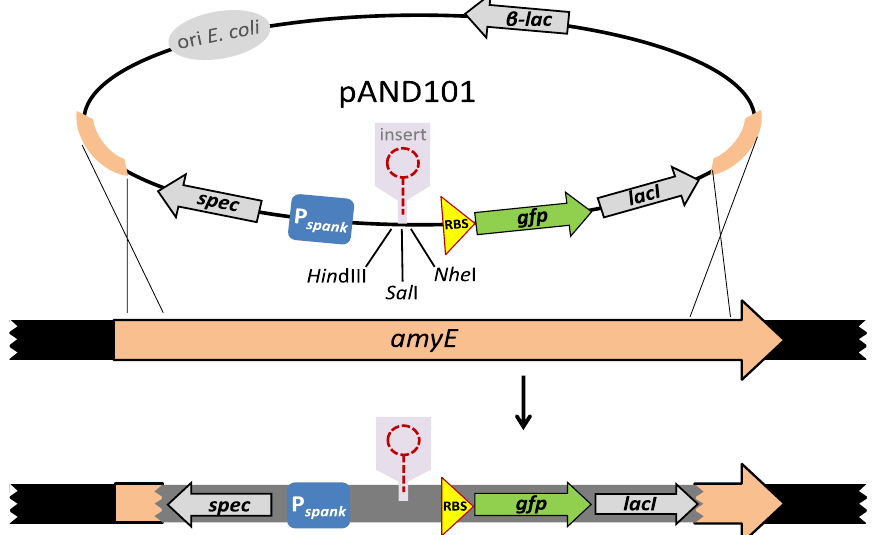
Figure 2. Features of the transcription terminator screening vector pAND101. Top: Vector pAND101 is a derivative of the B. subtilis amyE integration vector pDR110. A colE1 origin of replication ( ori E. coli ) confers replication in E. coli and the β-lactamase gene (β-lac) provides resistance to ampicillin in E. coli . The remaining part of the vector corresponds to the cassette that becomes integrated at the amyE locus when the plasmid is introduced into B. subtilis cells by transformation. The regions cor- responding to the N- and C-terminal regions of the amyE gene are shown in orange. Bottom: Sche- matic presentations of the double cross-over recombination event. The genomic configuration of the B. subtilis amyE region of the chromosome in the parent strain and the resulting transformants are shown below the circular plasmid. The thick black lines at the two ends indicate B. subtilis chromo- somal DNA. The cassette that becomes integrated via double cross-over at the amyE locus (not to scale) encompasses the spectinomycin resistance gene (gray arrow indicated with “spec”), the lacI gene encoding the P spank repressor (gray arrow indicated with “ lacI ”), which is under the control of a constitutive promoter, and the gfp reporter gene (green arrow indicated with “ gfp ”) that is under the control of the IPTG-inducible P spank promoter (blue box indicated “P spank ”). The unique restriction sites Hin dIII, Sal I and Nhe I are located in between the P spank promoter and the ribosomal binding site (RBS, yellow triangle) of the gfp gene, and permit the insertion of a sequence of interest in front of the gfp reporter gene.